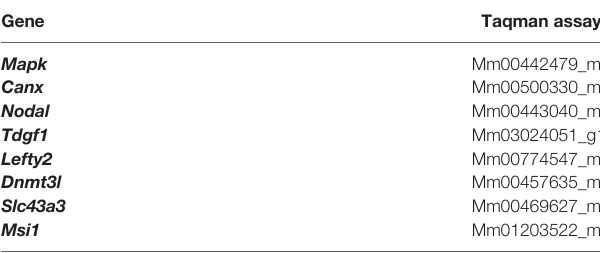
TABLE 2 | Taqman assays for Fluidigm analysis. Gene Taqman assay